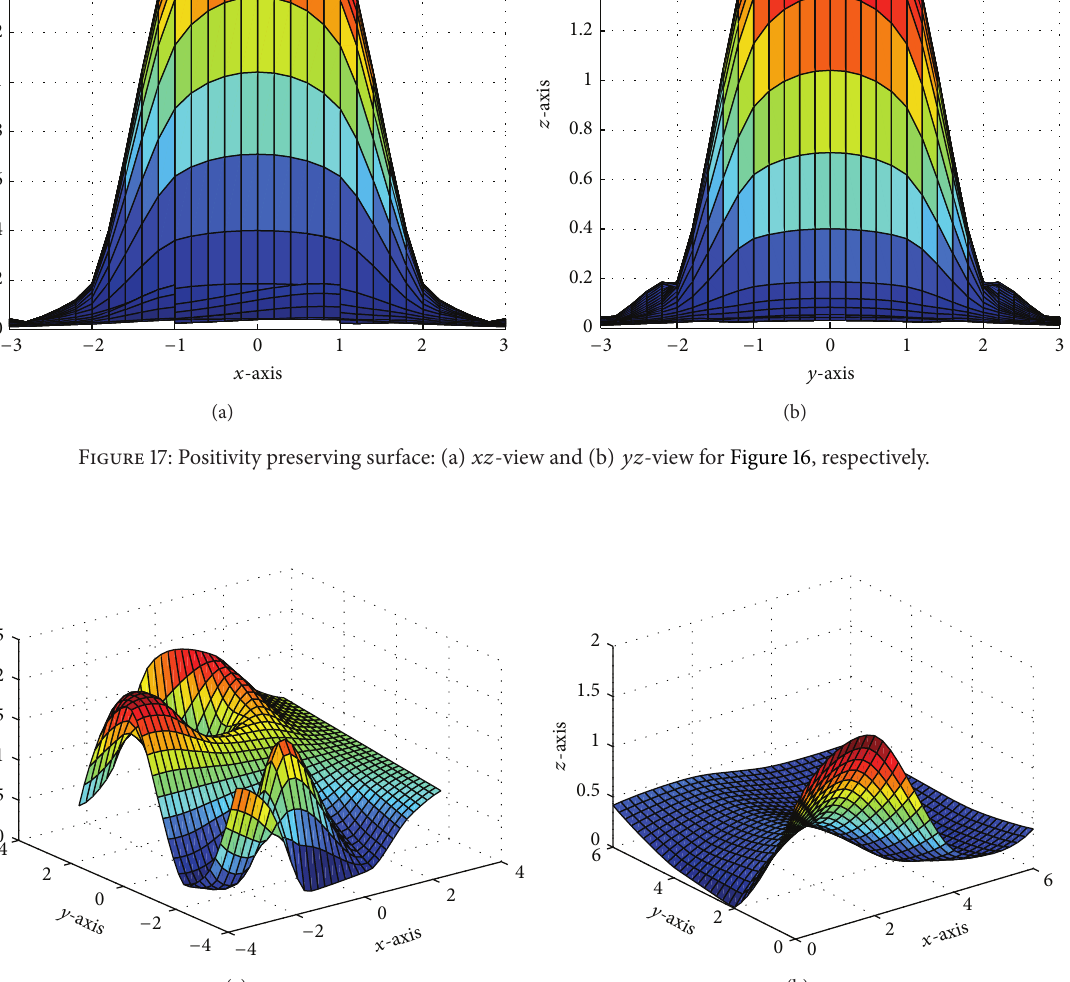
spline interpolation. Table 7 summarized the RMSE